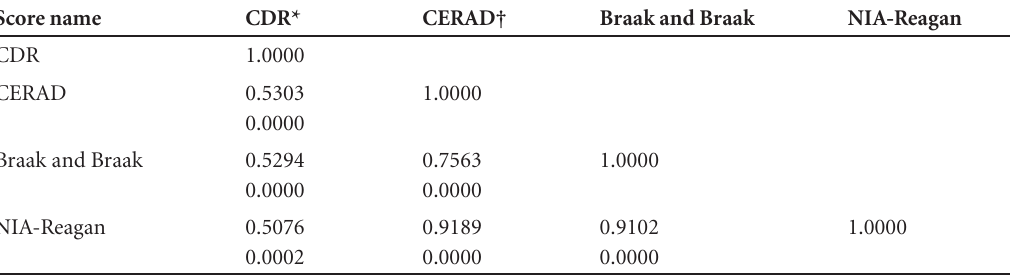
Table 4. Clinicopathological correlation by score. The r and p values are depicted on first and second lines,